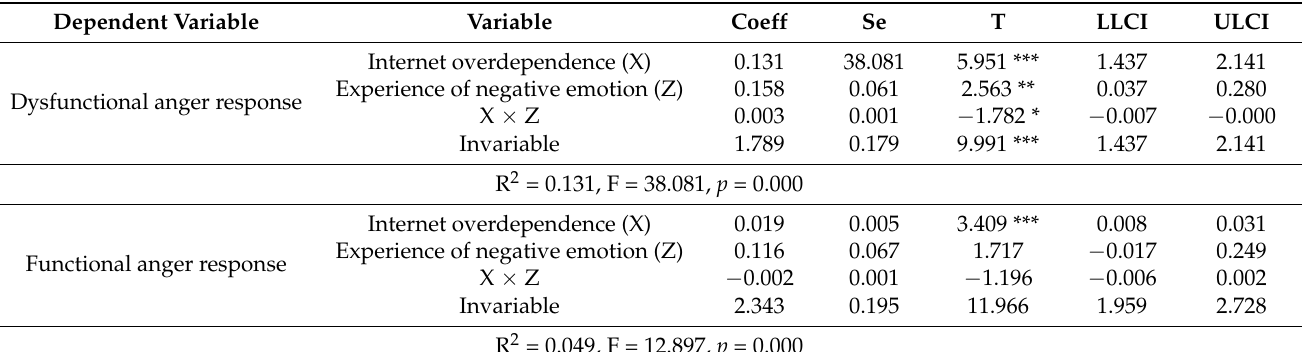
Table 4. Testing the hypothesis result of the moderating effect.